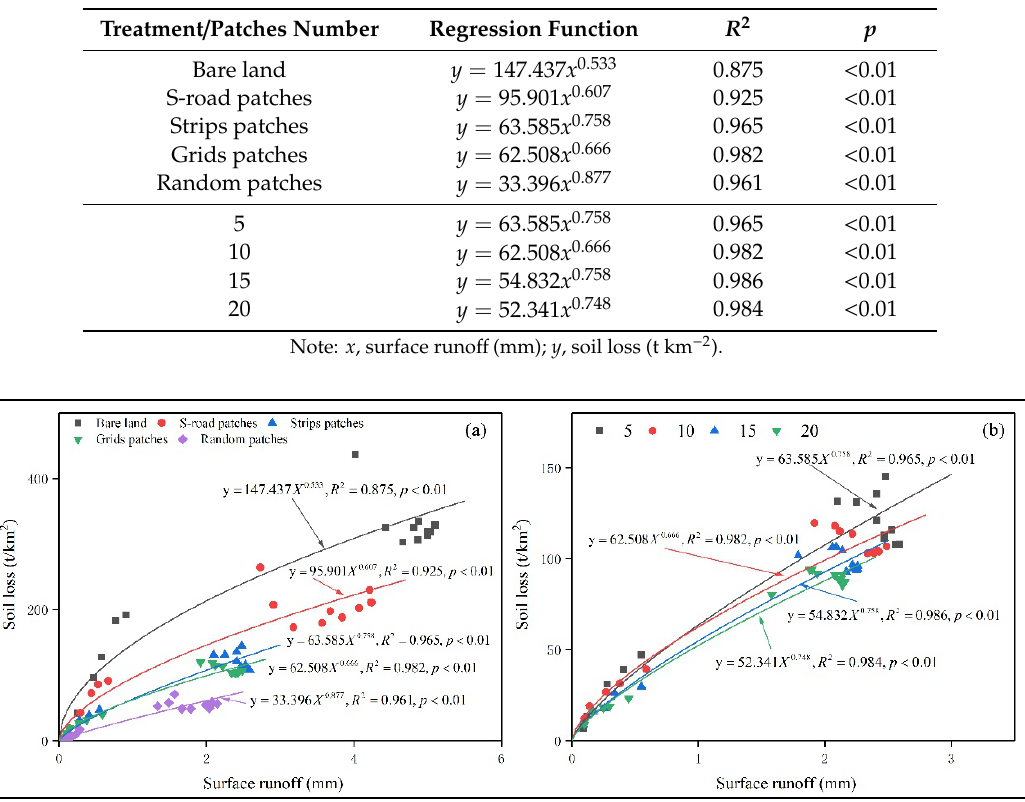
Figure 7. Between surface runoff and soil loss for different vegetation patch types ( a ) and numbers ( b ) within an experiment.